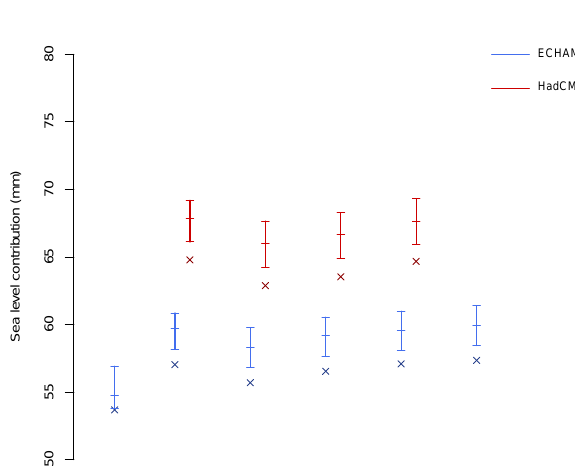
In other words, the parameterisation and ISM uncertainties increase by a factor of seven and six, respectively, between 2100 and 2200, while the difference between the two GCMs barely doubles. The relative contributions to our uncertainty thus depend on the timescale of